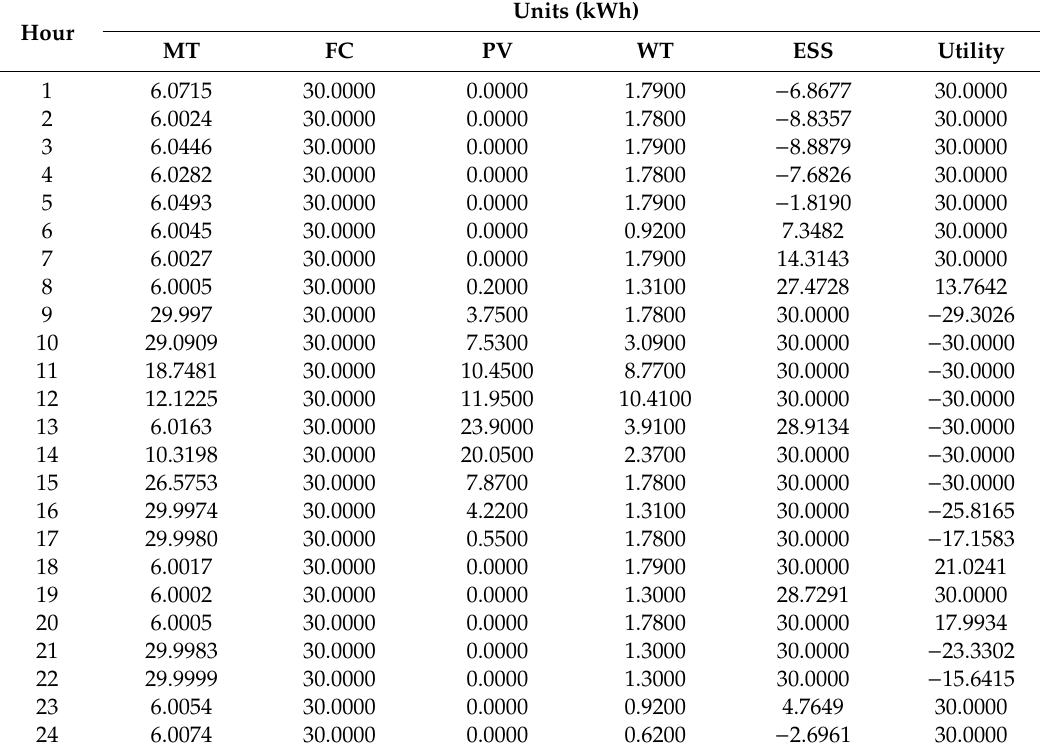
Table 6. Optimal power scheduling ( β =